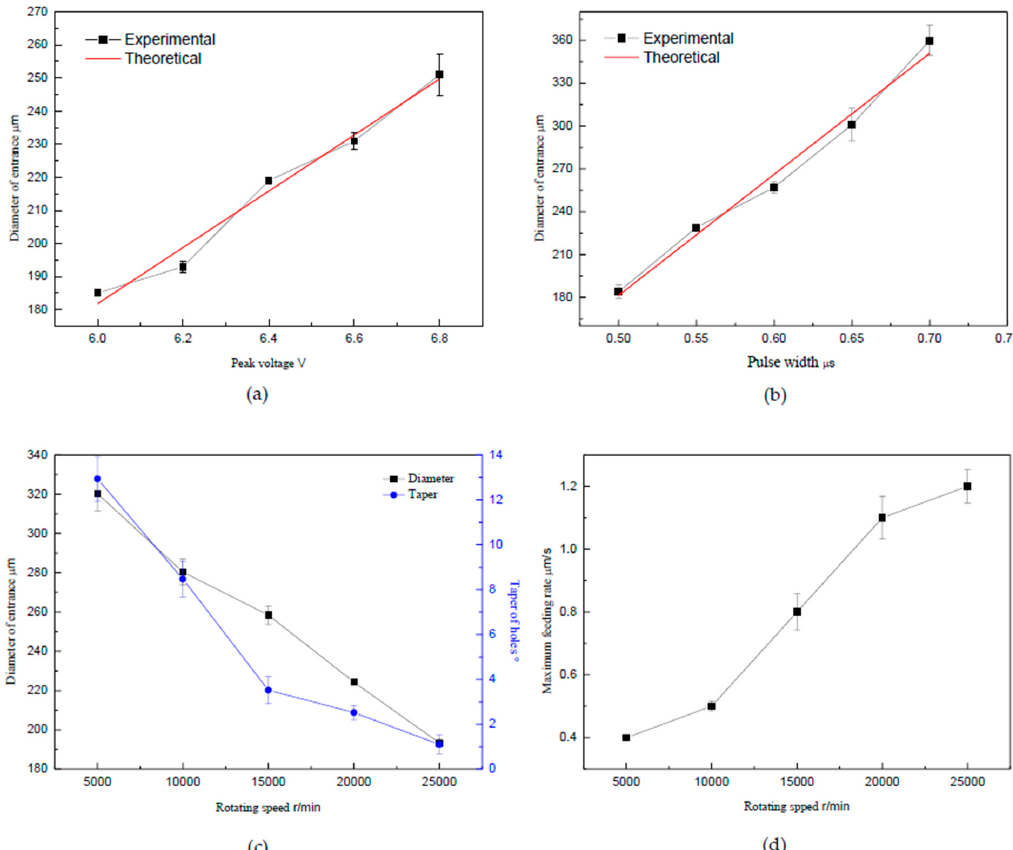
Figure 6. Curve of the diameter of entrance changing with the peak voltage: ( a ) curve of the diameter of entrance changing with the peak voltage; ( b ) curve of the diameter of entrance changing with the pulse width; ( c ) curve of the diameter of entrance and taper of holes changing with the rotating speed; and ( d ) curve of the maximum feed rate changing with the rotating speed.